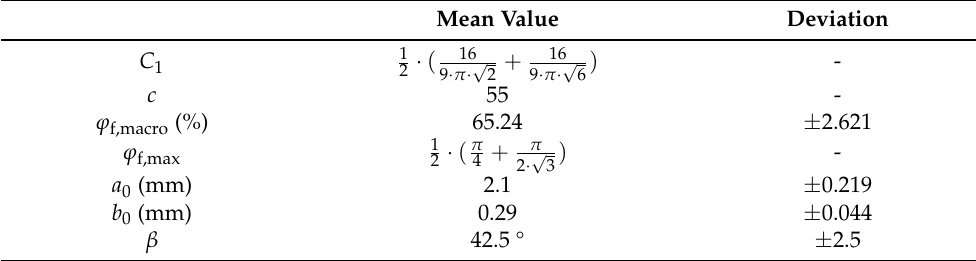
Table 5. Parameters for the permeability calculation.